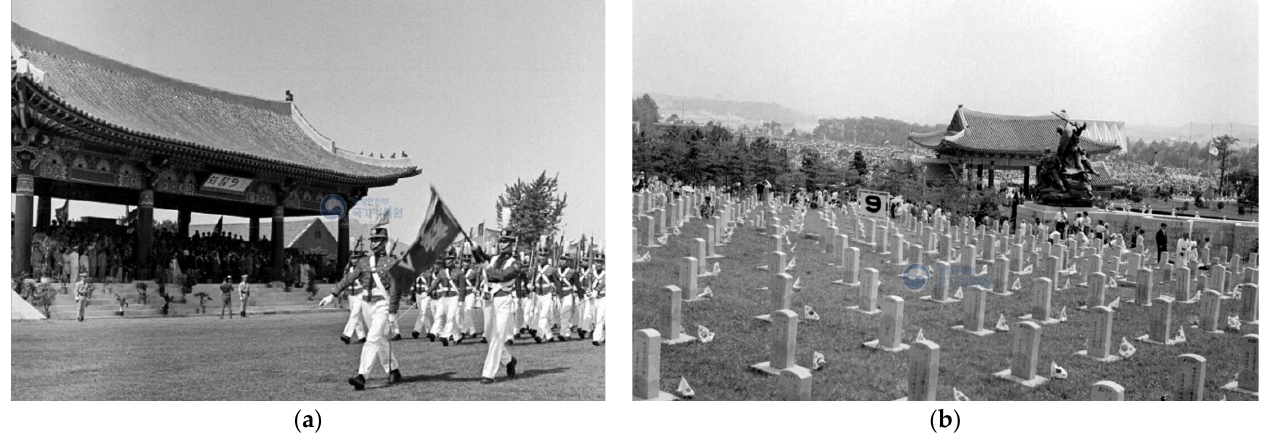
Figure 20. Examples of ‘Classical Architecture’ by Kang Bong-jin ( a ) Korea Military Academy– Hwarangdae (1966) ( b ) Hyeonchungmun Gate at Seoul National Cemetery (1969) (source: National Archives of Korea).